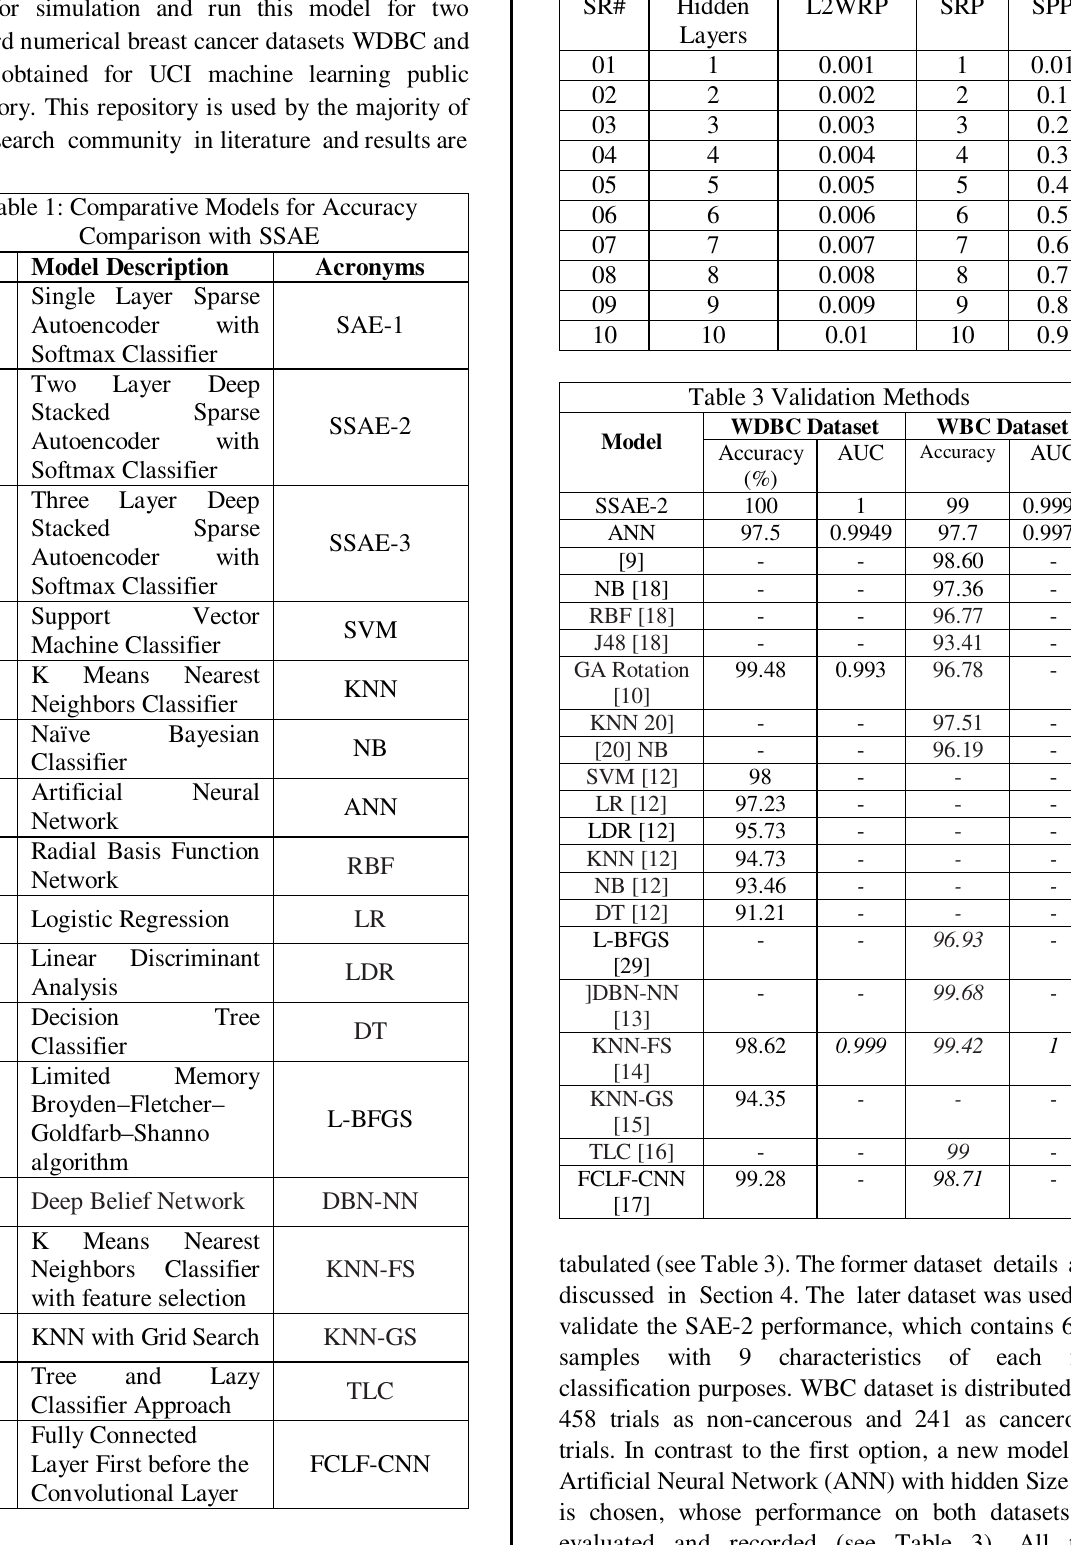
Table 2: Deep Neural Network (DNN) Parameters SR# Hidden